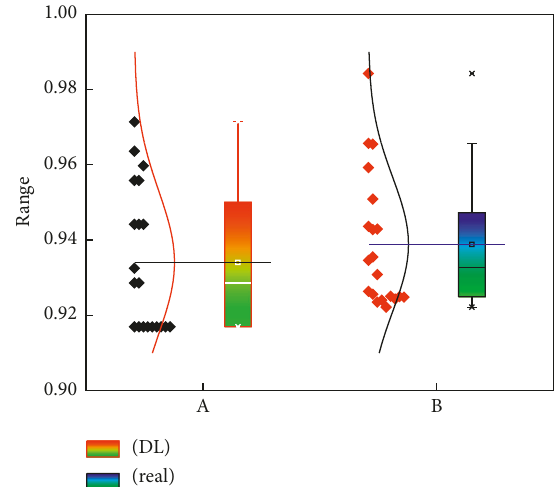
Figure 7: Box map distribution of predicted and actual values of sound features from the media.